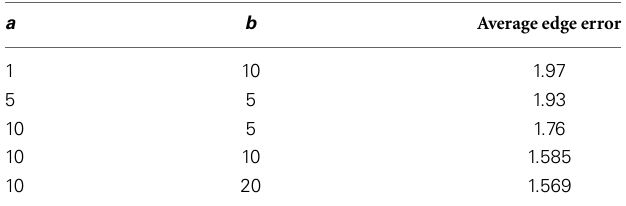
Table 1 | Average edge error using the attribute annotation of the training set, for different